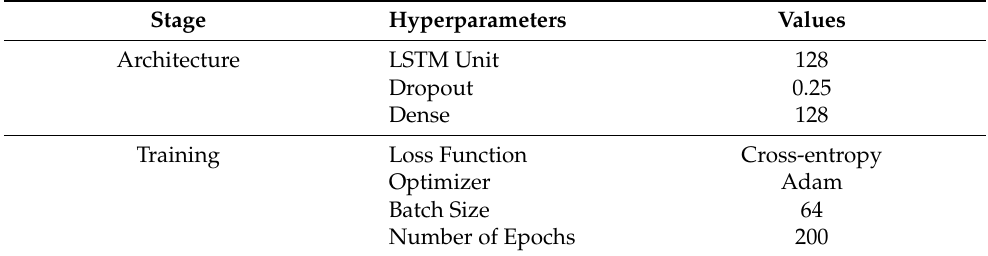
Table A2. The summary of hyperparameters for the LSTM network used in this work.